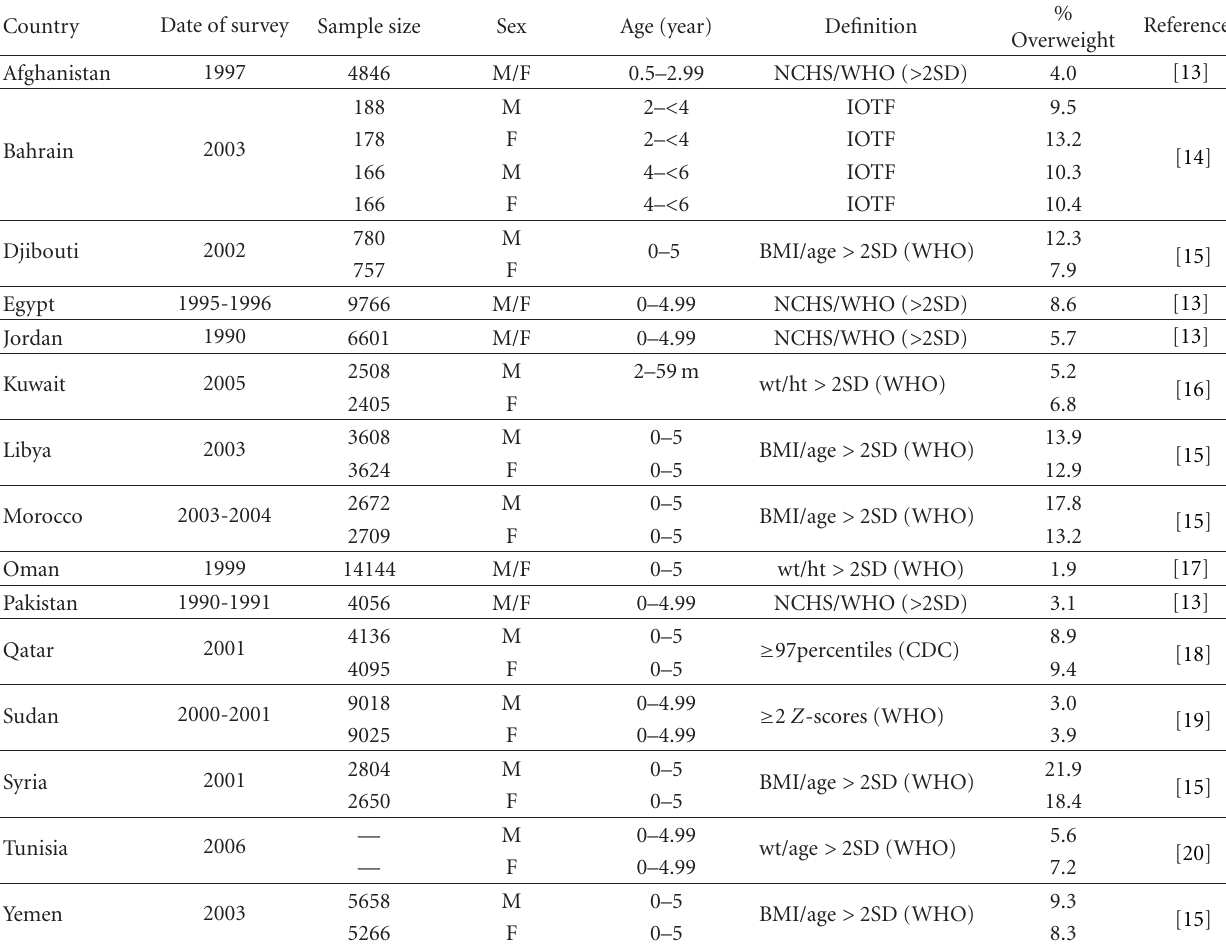
Table 1: National prevalence of overweight among preschool children (0–5 years) in selected EMR countries.